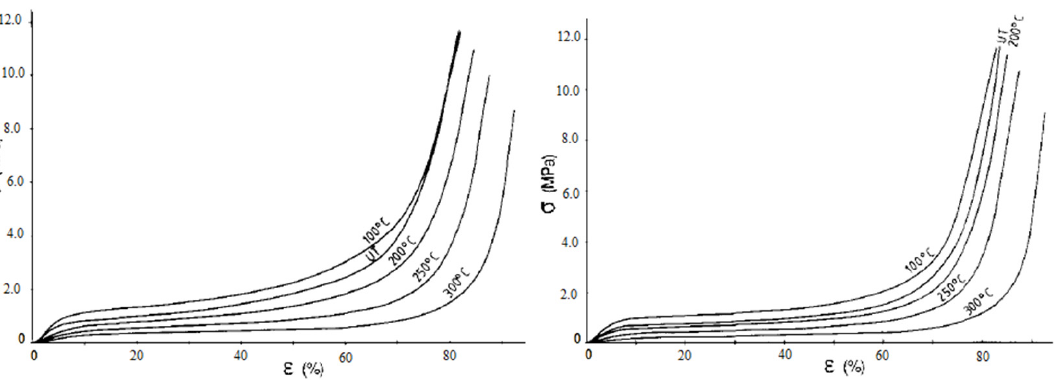
Figure 3. Compressive curves along the radial and axial directions of untreated (UT) and 1 hour thermally treated corks (Reprinted with permission from [32]).